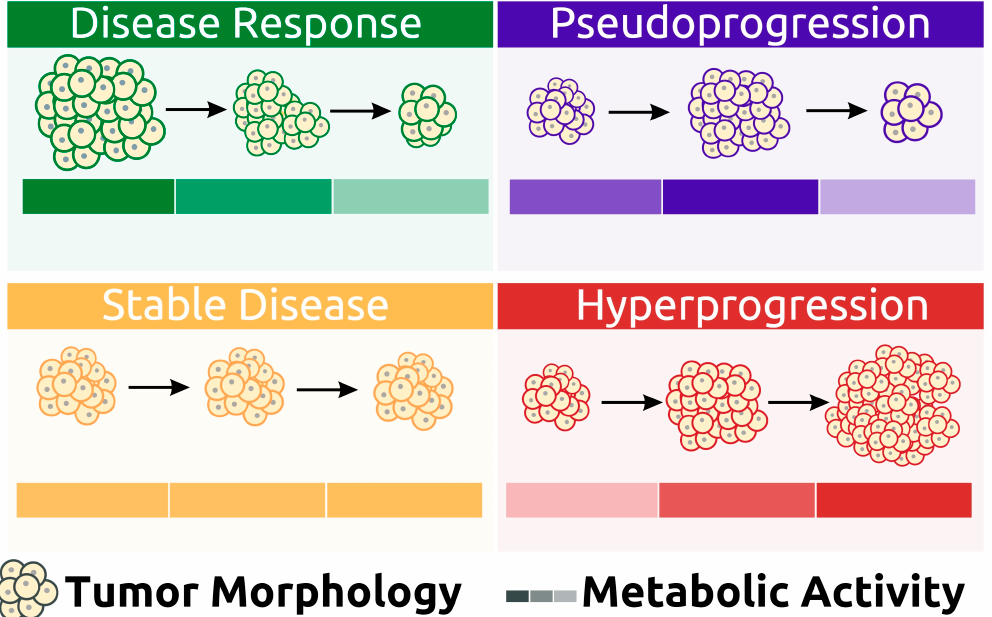
Figure 2. Graphical presentation of different response patterns achieved after lymphoma immuno- therapy administration. apy